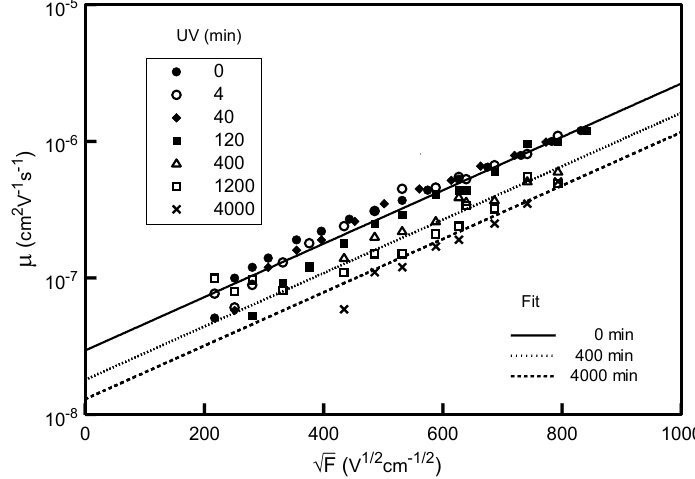
Figure 1. Hole mobility data recorded for a series of DEH MDP films that have been subjected to the UV exposure periods indicated. The solid lines show the optimised fit of Equation (1) to selected samples using adjustable values of μ 0 .